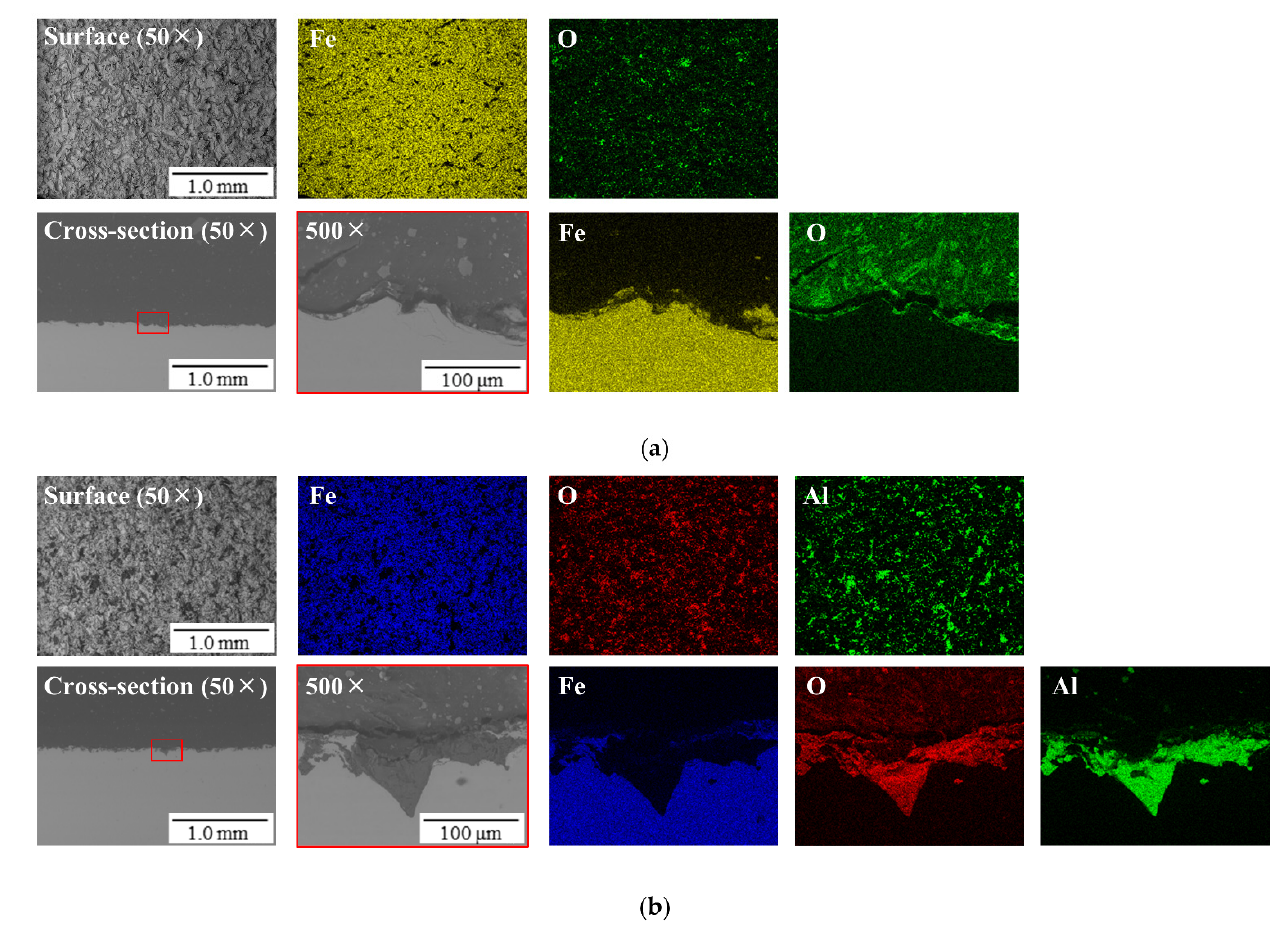
Figure 3. SEM-EDX analysis of the surface and cross-section of the specimens subjected to blasting: ( a ) MST, ( b ) MAL.